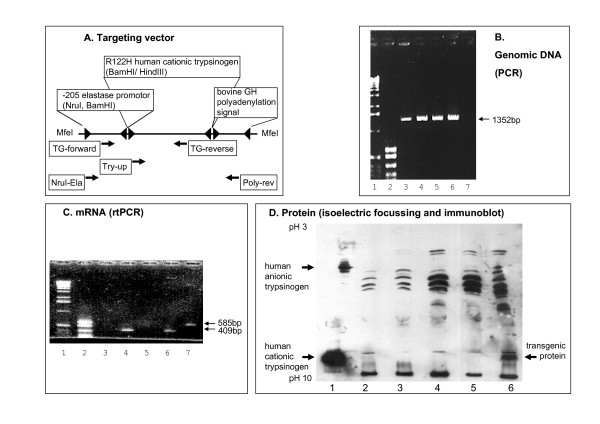
a. Schematic illustration of the targeting vector: The vector is carrying the minus-205 fragment of the rat elastase promotor, the Kozak consensus, the cDNA of human cationic trypsinogen with the R122H mutation, and the bGH-polyadenylation signal of the bovine growth hormone. The position of the PCR primer for the verification of the transgene on genomic and on mRNA levels (NruI-Ela and Poly-rev) as well as the controls are indicated (TG-forward, TG-reverse, TryUp) b. Verification of the transgene in genomic DNA: Lane 1: 1000 bp marker, lane 2: 100 bp marker. Genomic DNA from transgene animals (lane 4–6), positive control (targeting vector diluted 1:10 000, lane 3), and negative control (water, lane 7) were used as a template with primers spanning the elastase promoter, the cDNA of human cationic trypsinogen, and the polyadenylation signal of the bovine growth hormone (NruI-Ela and Poly-rev). The PCR resulted in a single band of the expected size of 1352 bp. c. Verification of transgene on mRNA level: After mRNA preparation from pancreatic tissue a reverse transcription PCR was performed with either two upstream primers complementary to cationic trypsinogen (pTry) (used in lane 3, 4, 6) or to the elastase promotor (TG-forward) as a control. The downstream primer was complementary to trypsinogen (TG-reverse) (used in lane 5 and 7). Position of the primers see figure 1a. lane 1: 1000 bp marker, lane 2: 100 bp marker, lane 3: water control, lane 4: cDNA from a transgenic animal; PCR product with the expected size of 409 bp, lane 5: cDNA from a transgenic animal; no PCR product, lane 6: positive control for lane 4: targeting vector diluted 1:10 000, lane 7: positive control for lane 5: targeting vector diluted 1:10 000. d. Verification of the transgenic protein: Zymogene preparation from mouse pancreata or pancreatic juice were subjected to isoelectric focussing followed by western blot using a antibody directed against human cationic trypsinogen (lane 1: pancreatic juice; lane 2–5: control animals; lane 6: transgenic animal)